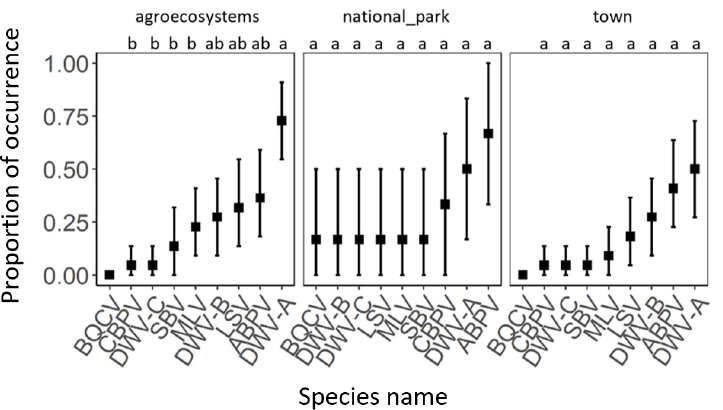
Figure 6. The comparison of proportion of viral pathogen occurrence within each habitat type. Black squares represent means and the error bars represent 95% confidence intervals. Significant differences (<0.05) are indicated by different letters.